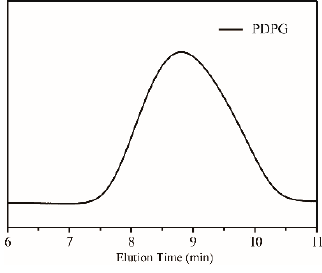
Figure 2. The gel permeation chromatography (GPC) trace recorded for PDPG.